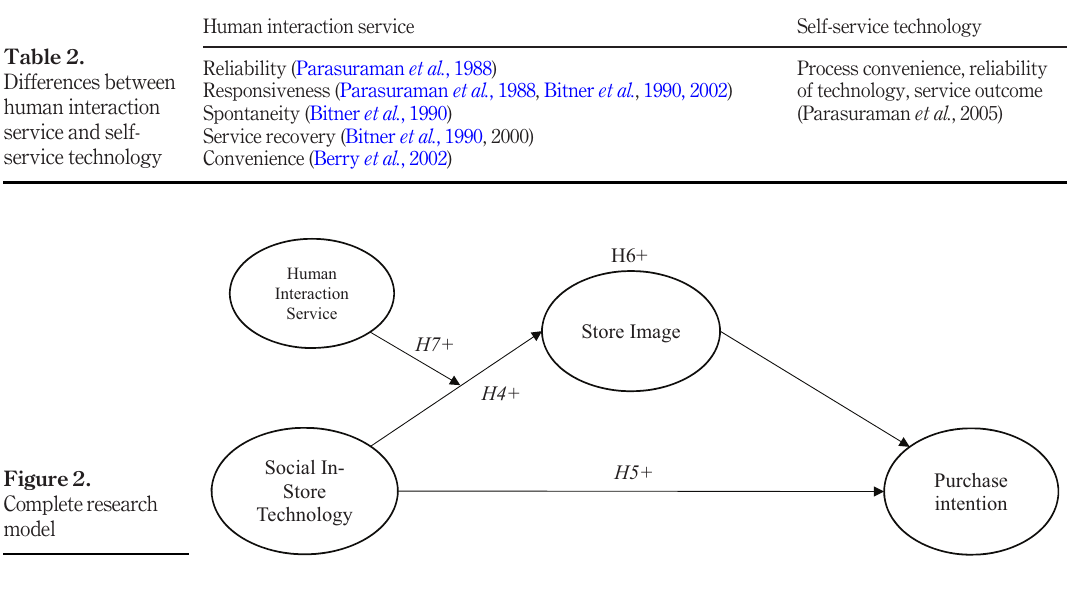
Figure 2. Complete research